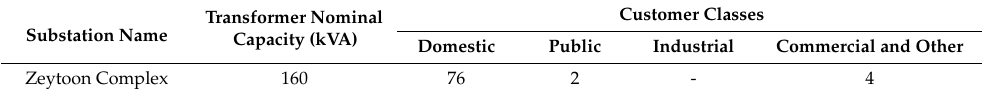
Figure 6. Domestic load density of Galougah [50]. Table 1. Specifications of the data logger installation